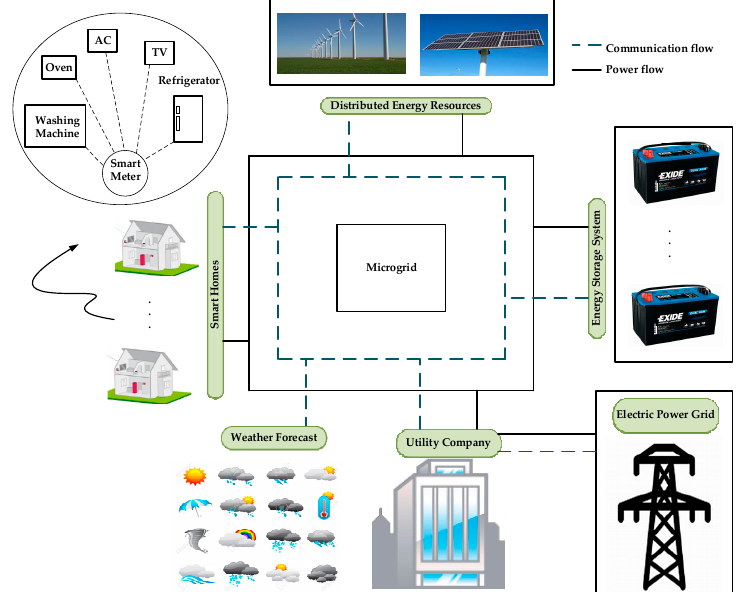
Figure 1. Framework for microgrid-level energy management.